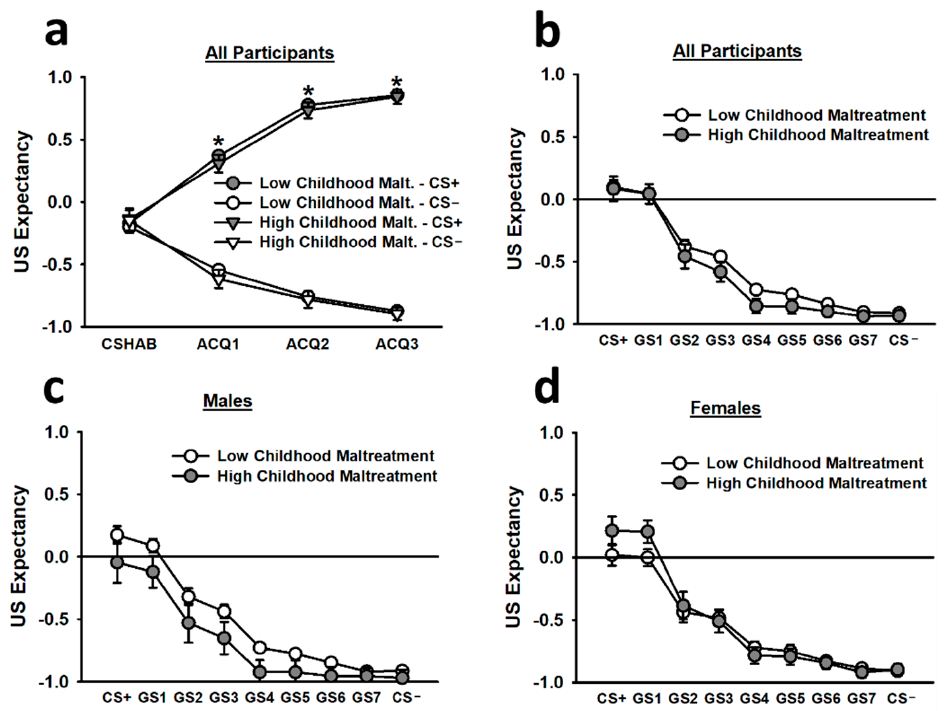
Figure 4. Subjective US expectancy ratings during the acquisition ( a ) and generalization ( b – d ) phases. According to the top left figure inset ( a ), participants demonstrated statistically equivalent US expectancy ratings for the CS+ and CS − during the non-reinforced CS habituation block (CS HAB). However, during the first, second, and third blocks of reinforced acquisition trials, participants exhibited significantly greater US expectancy ratings for the CS+ than for the CS − . During the generalization phase, participants, overall, displayed significantly greater US expectancy ratings for the CS+ and GS1 than for all other stimuli ( b ). This effect was observed in both males ( c ) and females ( d ). Data are means ± SEM. * p < 0.001 relative to CS − .